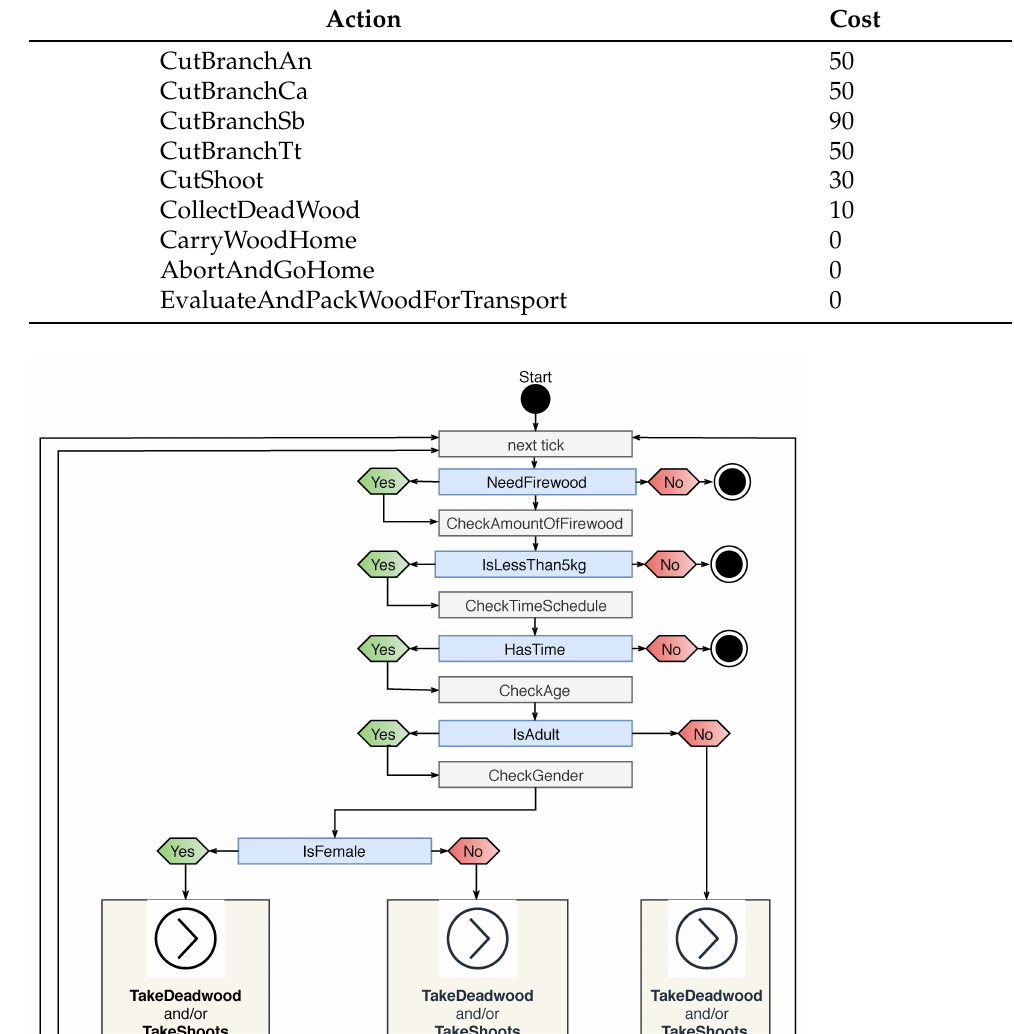
Table A3. Actions and cost for firewood collection.